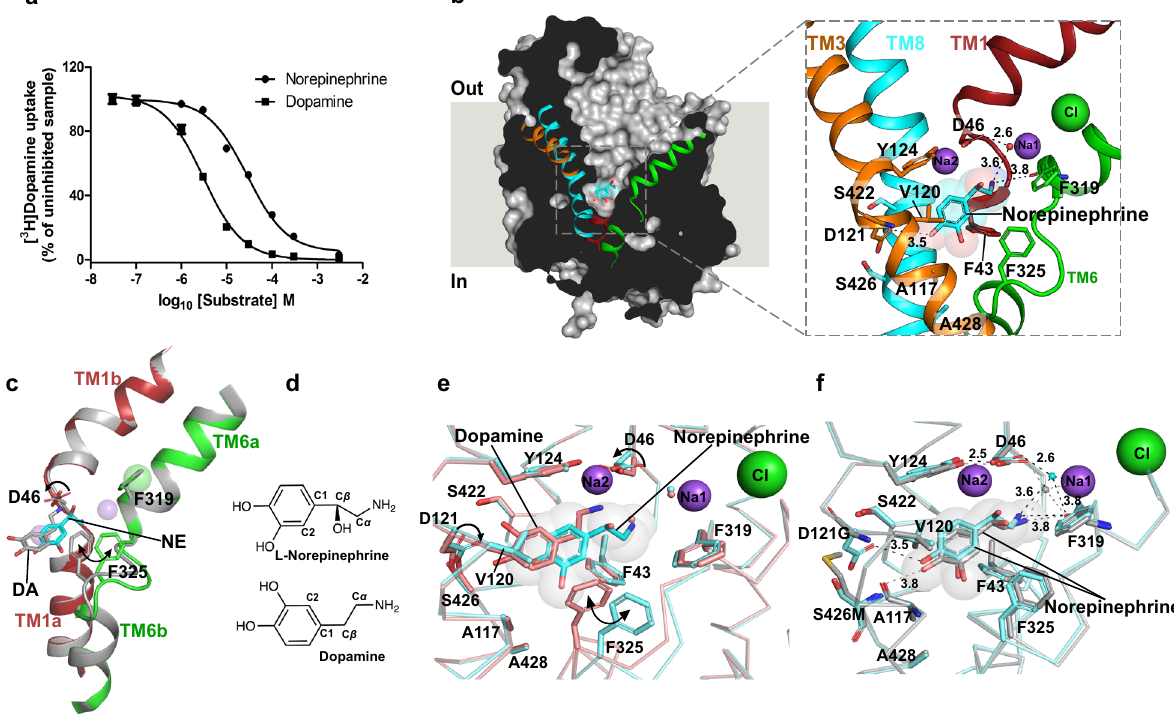
Fig. 2 NE binds in a different pose in comparison with DA-bound dDAT. a Inhibition of [ 3 H] dopamine uptake by dopamine and L -norepinephrine with inhibition constants ( K i ) of 2.0 ± 0.14 μ M and 19.1 ± 1.7 μ M, respectively. The data in the plot is a mean of n = 9 measurements obtained over three independent experiments and error bars representing s.e.m. b Longitudinal section of L -norepinephrine (NE)-dDAT mfc complex with L -norepinephrine displayed as cyan spheres. Close-up view of the L -norepinephrine in the primary binding site with surrounding residues displayed as sticks. Hydrogen bond interactions are depicted as dashed lines. c An overlay of TMs 1 and 6 display no change in helix positions, but highlights a shift in the main chain of the TM6 linker (C α rmsd of 1.4 Å between residues 322 and 326) between the dopamine (DA) bound (gray) and norepinephrine (NE) bound structures (colored helices). d Chemical structures of L -norepinephrine and dopamine displayed to highlight differences in binding poses. e Comparison of binding pockets of NE-dDAT mfc complex (NE in cyan and backbone in aquamarine) and DA-dDAT mfc (PDB id. 4XP1) complex (DA in deep salmon and backbone in salmon). The D46 sidechain remains in a position similar to antidepressant-bound structures of dDAT ( χ 1 torsion angle + 85°) unlike the dopamine bound structure ( χ 1 torsion angle − 175°). The D121 (TM3) residue in subsite B also shifts ( χ 2 shifts by 16°) to interact with NE in comparison with the DA-bound dDAT structure. The position of F325 shifts by nearly 2 Å (C β ) with a corresponding rotation of the phenyl group by 51° ( χ 2 torsion angle CD1-C γ − C β -C α ). f Superposition of binding pockets of the NE-dDAT mfc structure (NE and backbone in cyan) with the binding pocket of the NE-dDAT NET structure carrying hNET-like mutations in subsite B (NE and backbone in gray). NE was modeled into densities at near identical positions in both the structures. Source data are provided as a Source Data fi le.